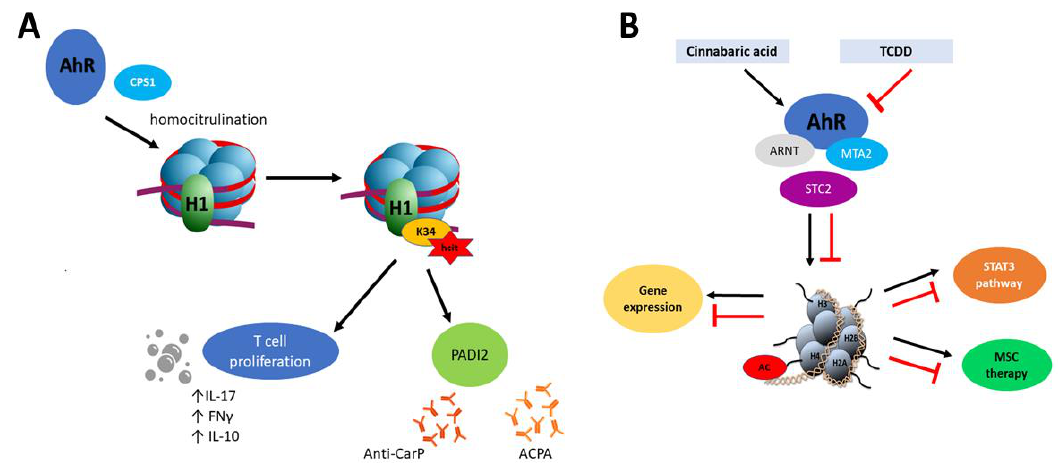
Figure 2. ( A ) Mechanism of homocitrulination and anti-CarP and anti-citrullinated protein (ACPA) antibody production. AhR recruits CPS1, which is responsible for homocitrulination of H1K34. H1K34 hct enhances PADI2 expression, a ff ects proliferation of T cells and production of IL-10 and the pro-inflammatory cytokines IFN- γ and IL-17. PADI2 plays a role in anti-CarP and ACPA antibody production. ( B ) Histone acetylation mediated by AhR. Cinnabaric acid (but not 2,3,7,8-tetrachloro- dibenzo-p-dioxin (TCDD)) activates AhR which recruits MTA2. Complex AhR / ARNT -MTA2 leads to transcriptional activation of STC2. MTA2 takes part in acetylation of histone 4. STC2 reveals anti-inflammatory properties which have been implicated into MSC therapy. STC2 also activates STAT3 signaling.